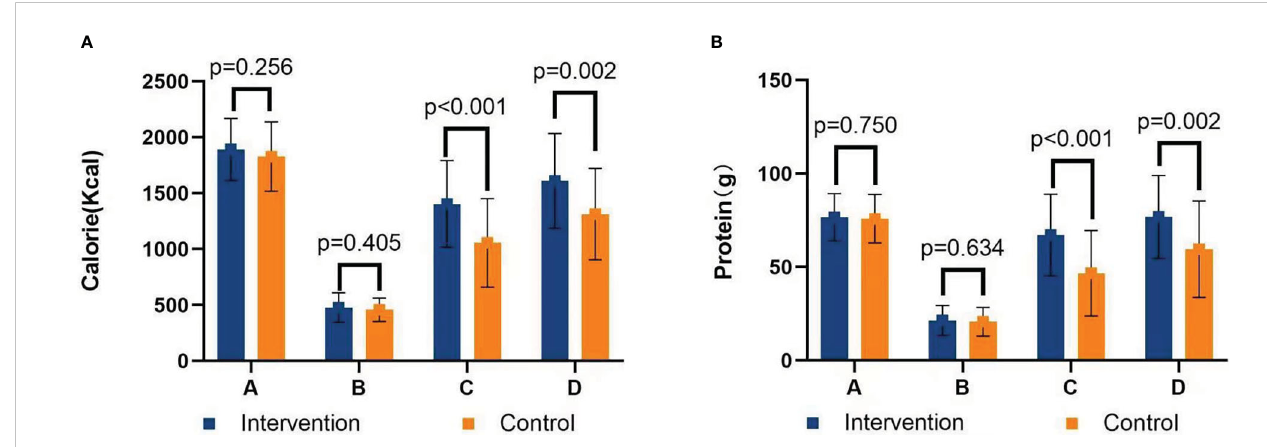
FIGURE 3 (A) Graph of intervention on BMI loss after total gastrectomy and proximal gastrectomy. (B) Graph of intervention on BMI loss after distal gastrectomy. A=Discharge day; B=30 days after surgery; C=60 days after surgery; D=90 days after